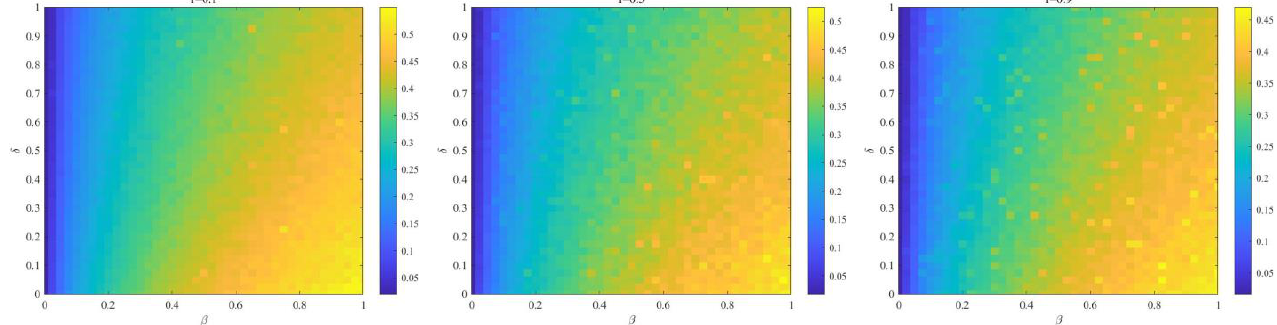
Figure 10. The full-phase diagram δ − β for different values of r . The color represents the proportion ρ R of recovered enterprise under steady state, other parameters are set as α = 5, m = 2, m 1 = 5, m 2 = 7, κ = 2, η = 0.8, µ = 0.8, λ = 0.8, γ = 0, θ =